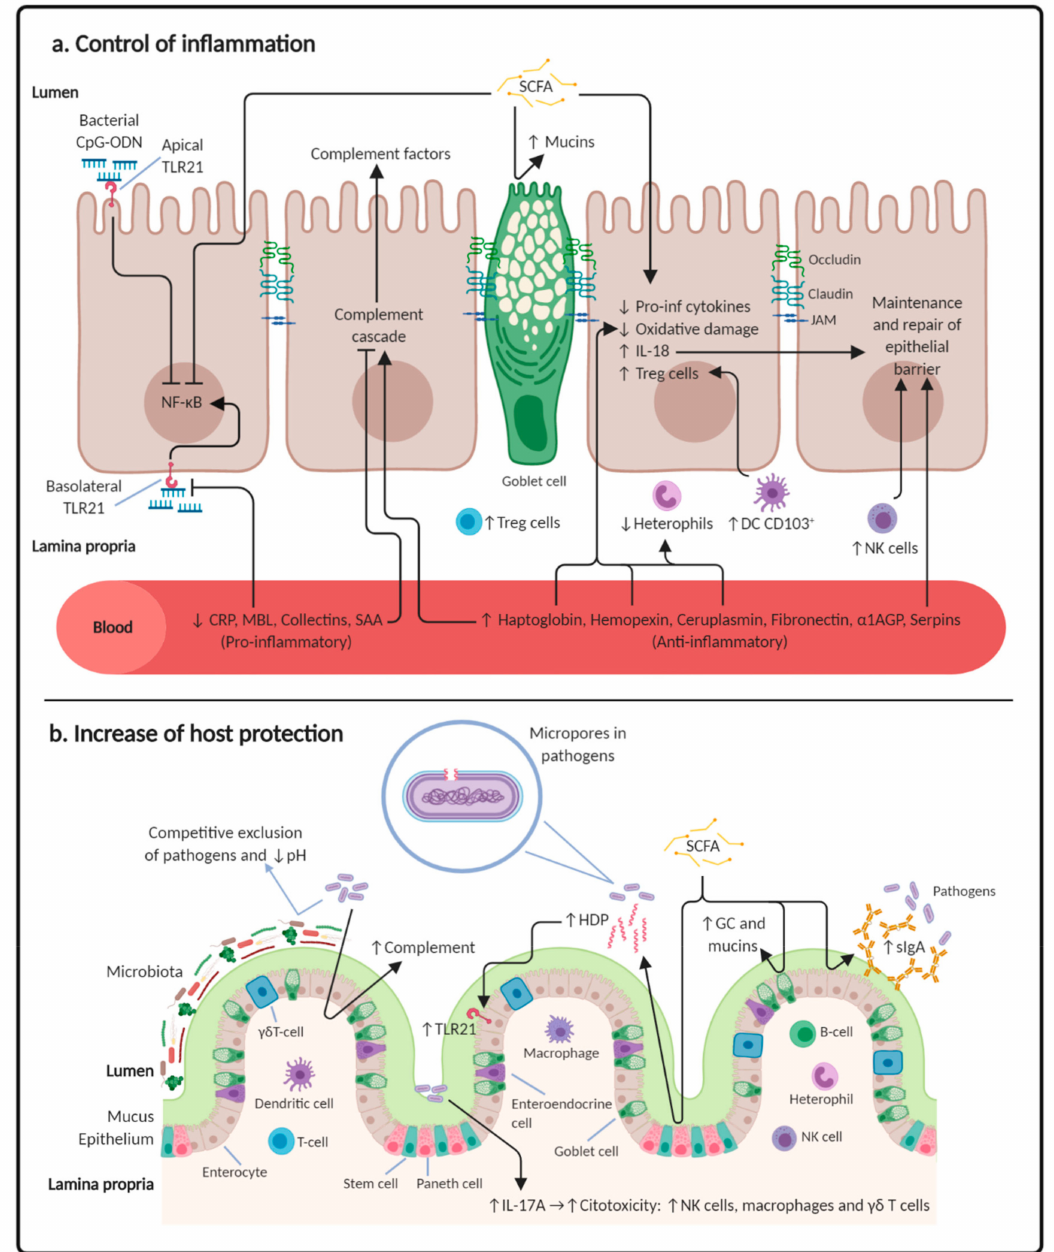
Figure 1. Putative mechanisms and immune pathways modulated by probiotics in the gastrointestinal tract of chickens: ( a ) by inducing a robust homeostatic status through promoting tolerance and preventing inflammation; ( b ) by increasing the luminal defence capacity of the host against pathogens. CpG oligodeoxyunucleotide sequences (CpG-ODN); nuclear factor-kappa B (NF- κ B); toll-like receptor (TLR); short-chain fatty acid (SCFA); interleukin (IL); dendritic cell (DC); natural killer (NK); C-reactive protein (CRP); mannose-binding lectin (MBL); serum amyloid A (SAA); α 1-acid glycoprotein ( α 1AGP); secretory immunoglobulin A (sIgA); host defence peptide (HDP); and goblet cell (GC). Figure created with